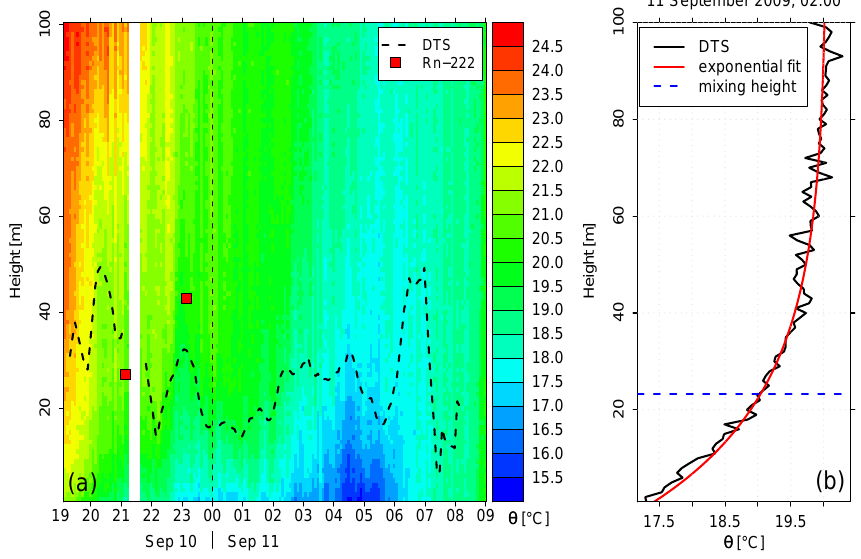
Fig. 4. (a) Evolution of potential temperature 2 during campaign 2 (10 September 7 p.m.–11 September, 9 a.m.). The bold dashed line and the red squares denote the mixing heights as determined from exponential profile fits and 222 Rn measurements, respectively. The white vertical band is a period of missing data; (b) Example of a DTS measurement profile for 11 September, 2 a.m. (black) and the corresponding best fit of an exponential curve (red). Mixing height H is shown in